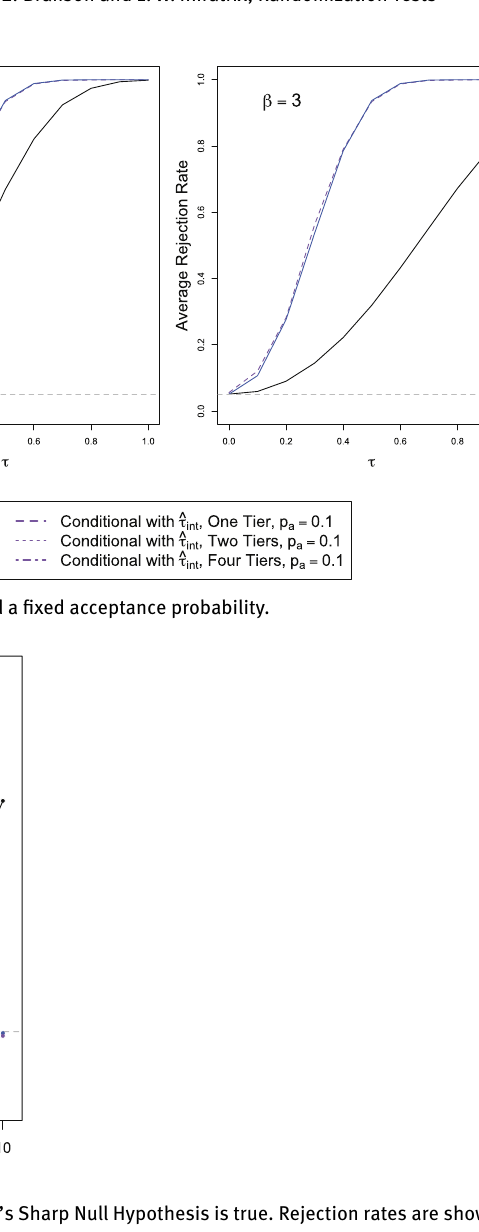
Figure 5: The unconditional and conditional performance of our conditional randomization test using ̂ τ int . Figure 5a is analogous to Figure 1a; Figure 5b is analogous to Figure